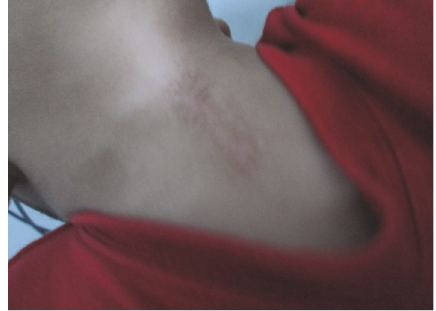
Figure 4: CMCC in a 2-year-old boy.